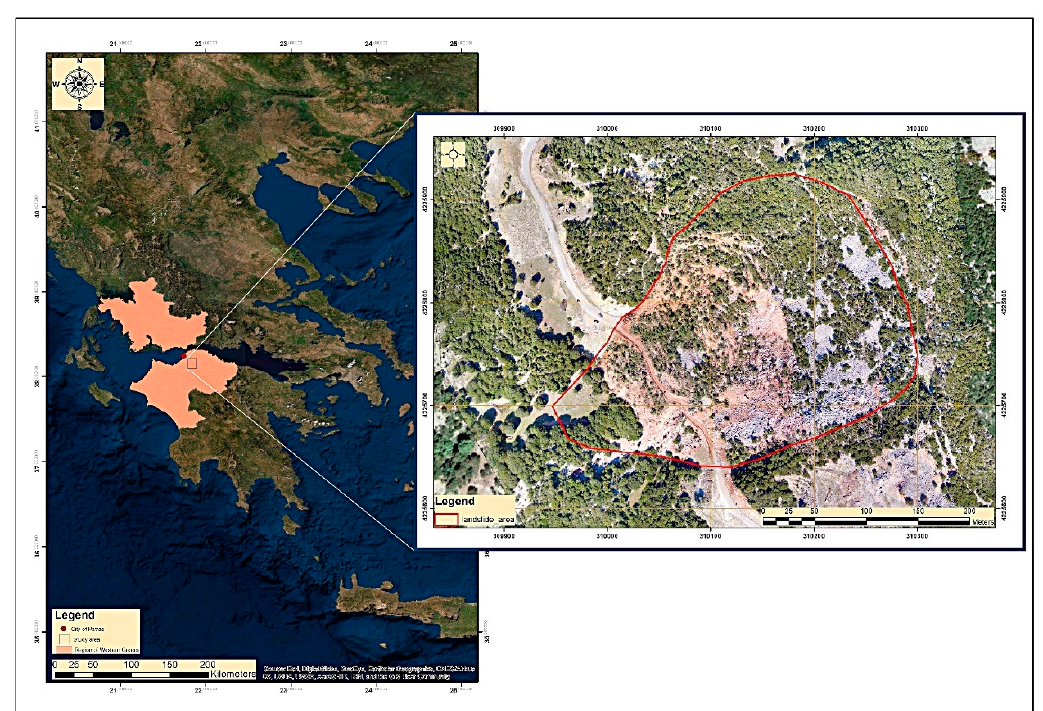
Figure 1. Location of the study area. The orange color represents the boundaries of the region of Western Greece, while the red dot and the blue rectangular display the location of the city of Patras and the study area, respectively.